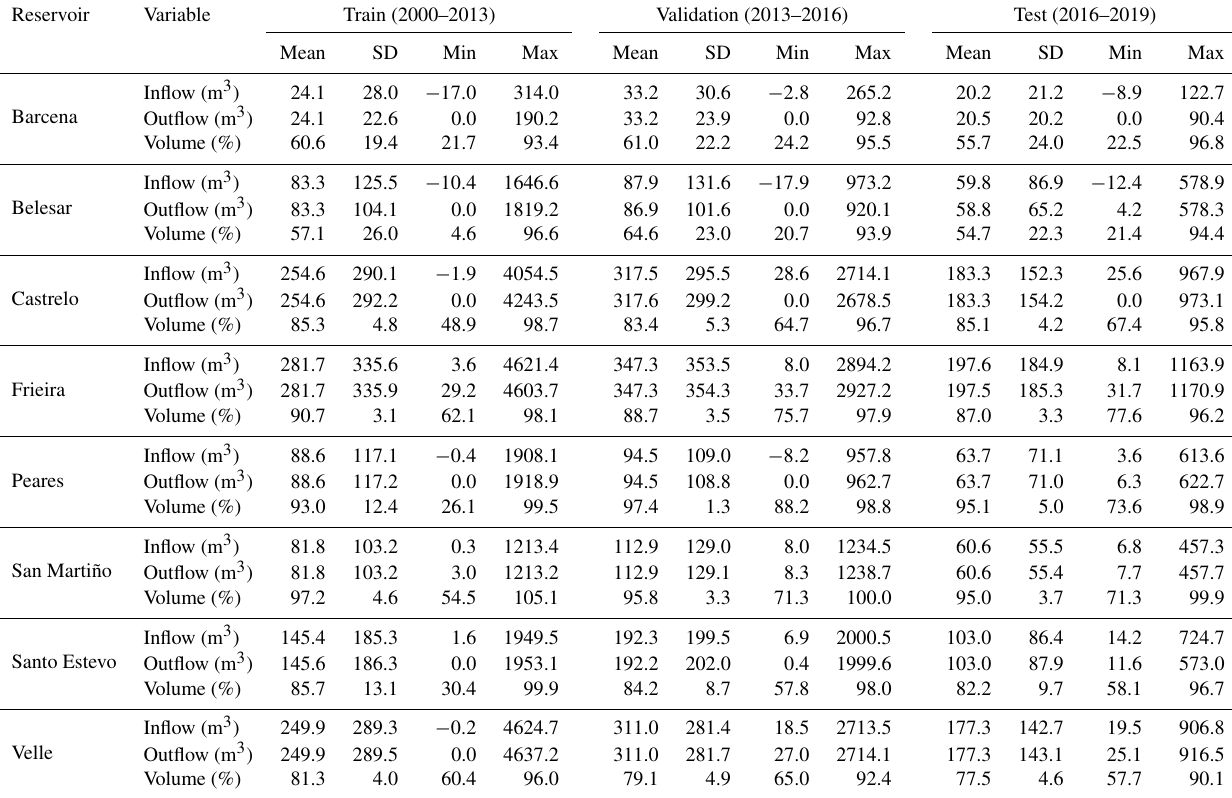
Table 2. Statistics of the variables used for the train, validation and test subsets. Reservoir Variable